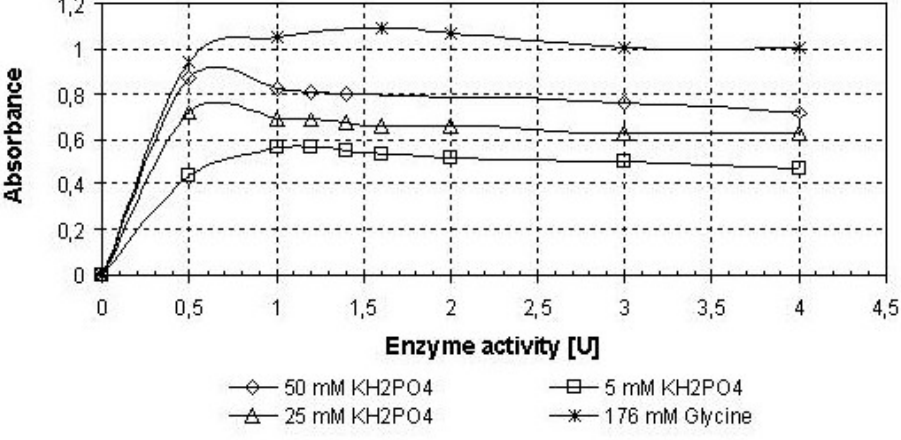
Figure 3. Dependence of the absorbance level on the enzyme activity (0.4 – 4 U/200 µl) and composition of the buffer solution: phosphate buffer KH pH 10.56, and glycine buffer of 176 mM of pH 10.56 for constant concentration of the cofactor 0.4